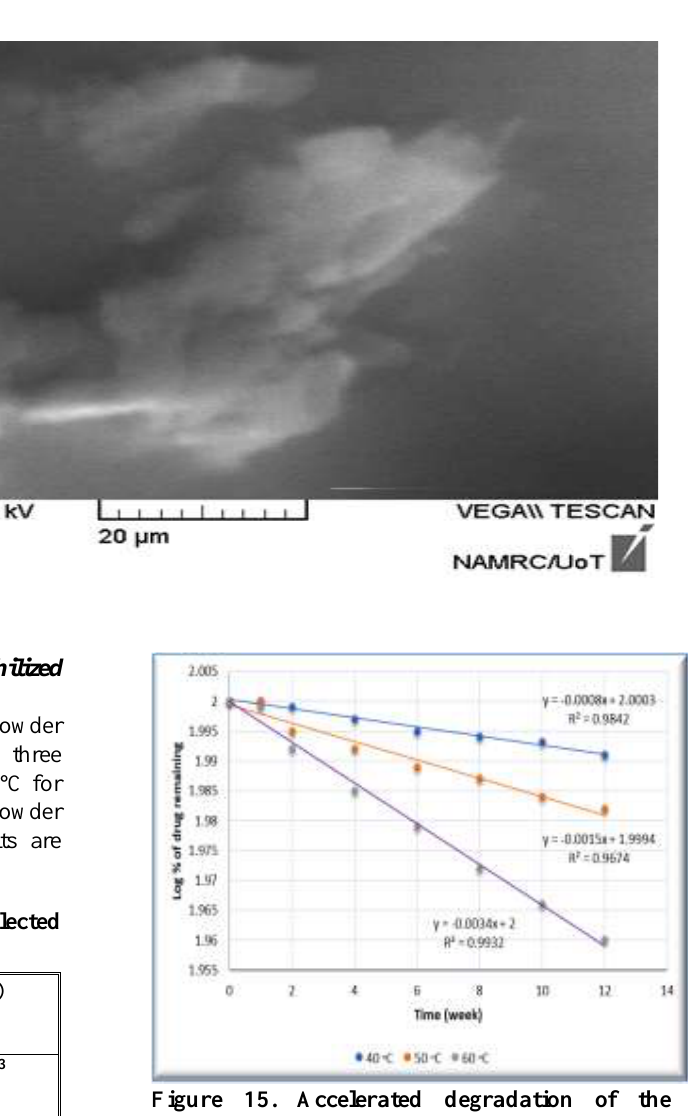
Figure 15. Accelerated degradation of the selected F13 lyophilized powder at 40 ⸰ C, 50 ⸰ C, and 60 ⸰ C